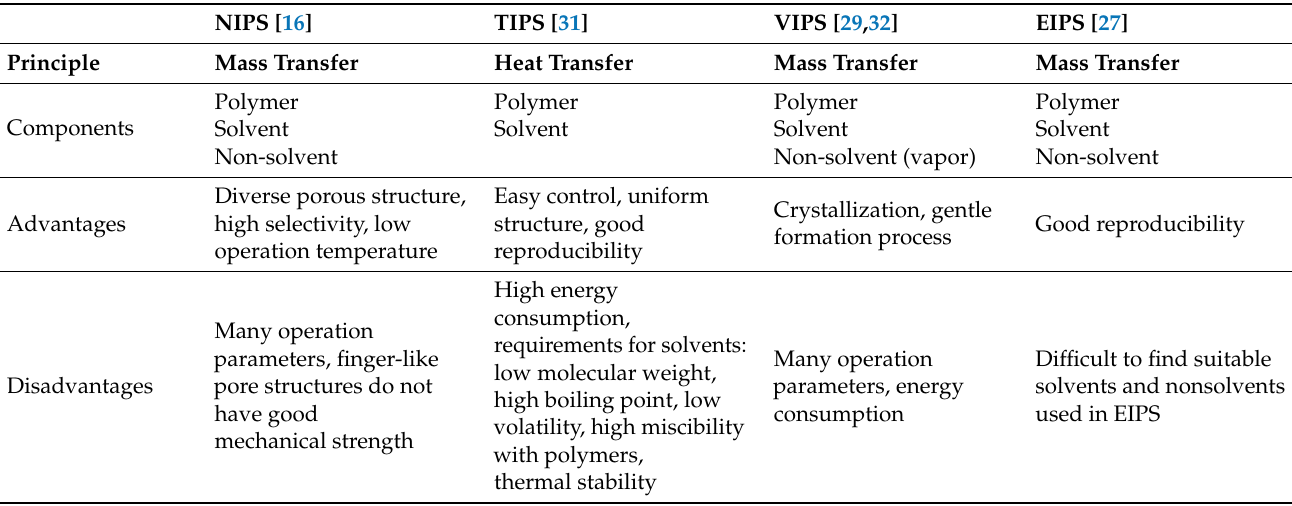
Table 1. Comparison of four phase separation methods [30].